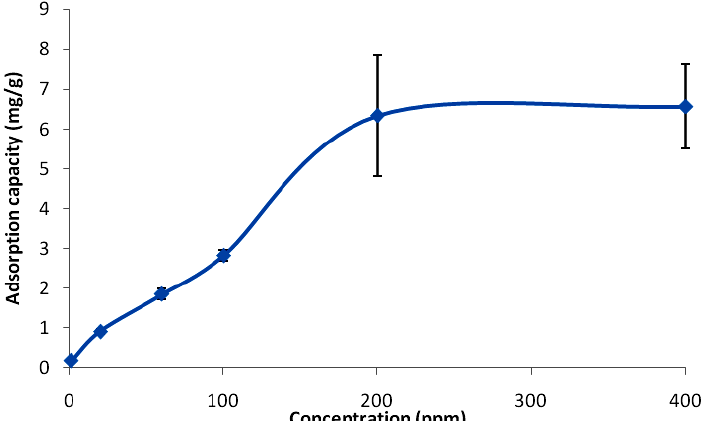
Figure 7. Adsorption capacity of various concentration of melamine by Mel-MIP-9VC. Dosage of MIP is 10.0